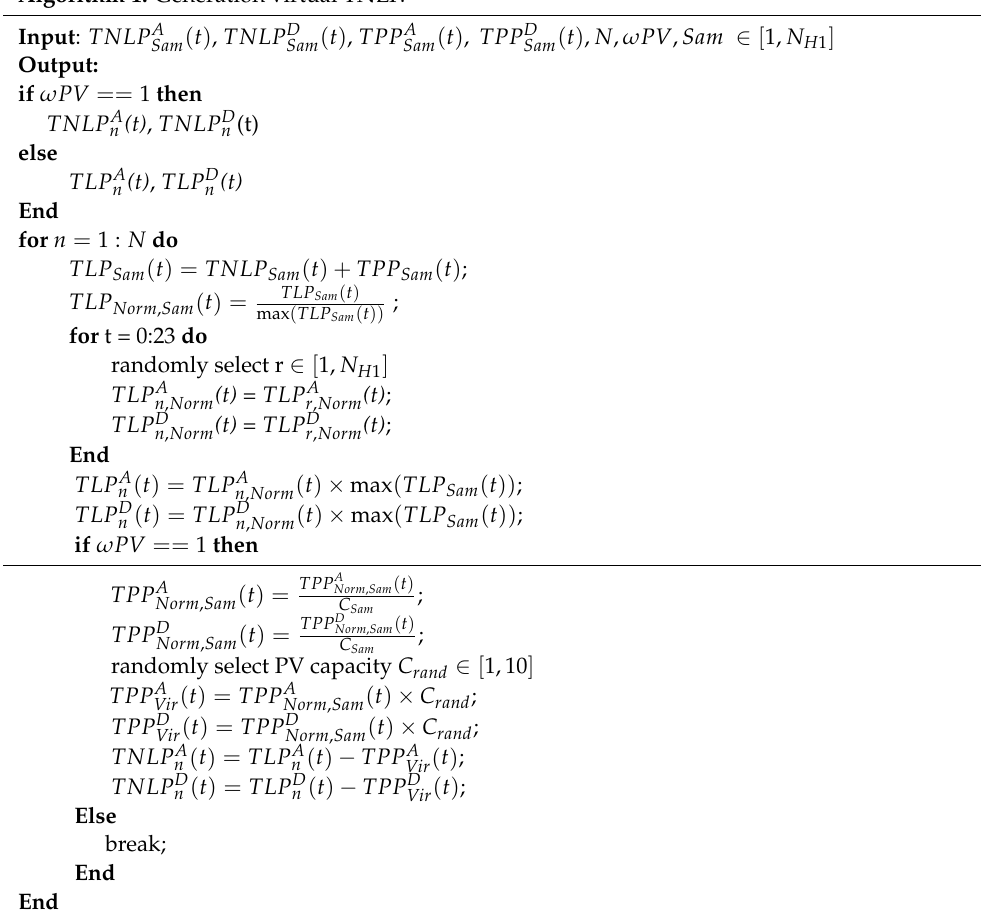
Algorithm 1. Generation virtual